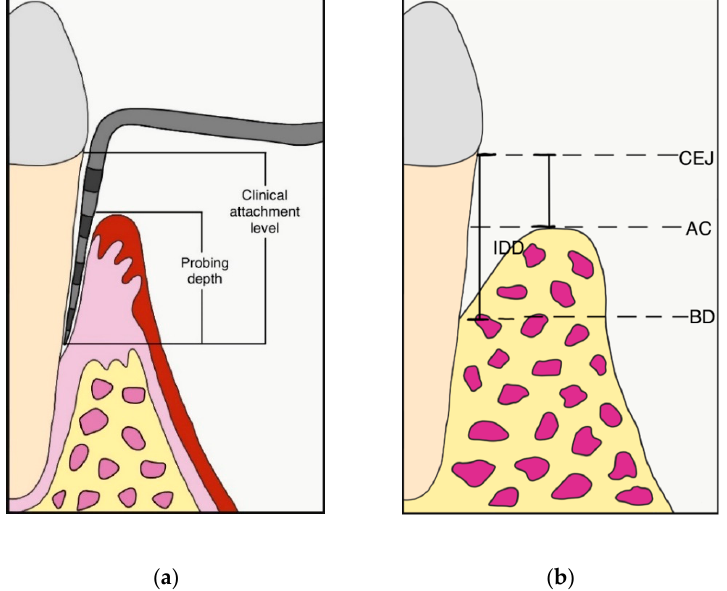
Figure 4. ( a ) Probing depth (PD) and clinical attachment level (CAL) measurement; ( b ) Intrabony defect depth (IDD) was defined as (CEJ-BD)—(CEJ-AC); CEJ: cement enamel junction; BD: bottom of the defect; AC: alveolar bone crest.